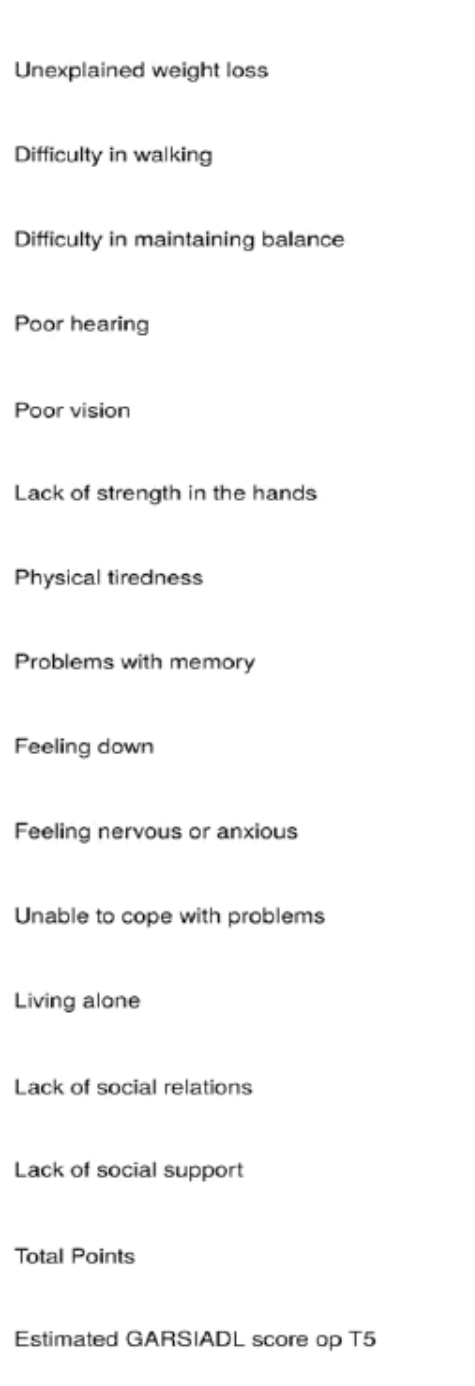
Figure A8. Nomogram IADL disability score at Figure 8. Nomogram IADL disability score at T5.